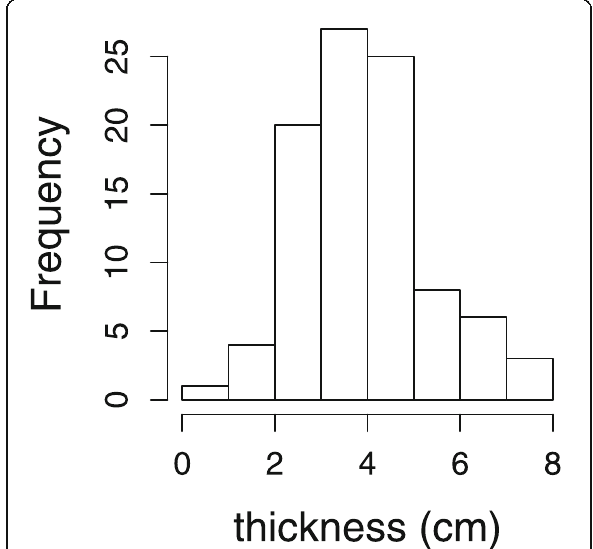
Fig. 5 Distribution of lichen-mat thickness in northern Sweden. Histogram of lichen-mat thickness in the boreal forests of northern Sweden. Data were collected in 2015 and 2016 in 94 forest stands located in the Swedish northern-most counties. See the section “ Data on lichen conditions ” for more